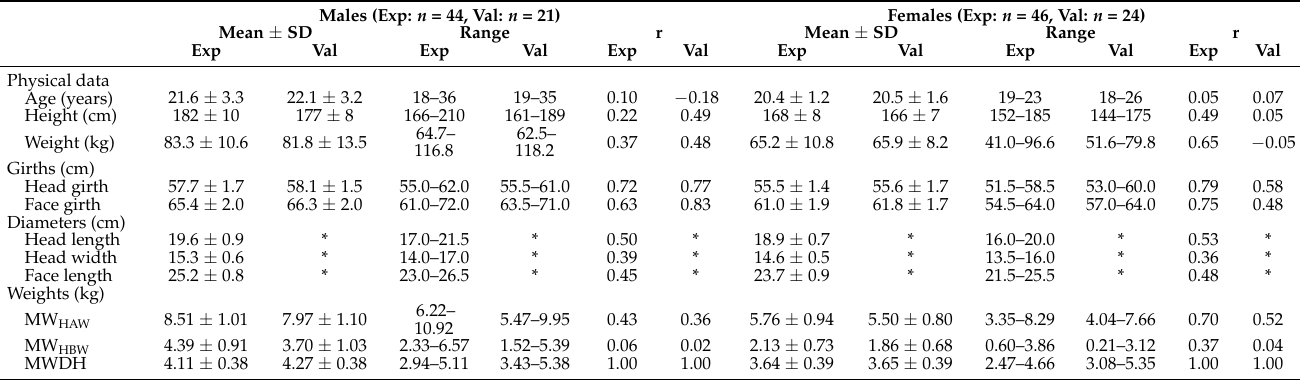
Table 1. Physical measurements and correlations with mass of water displaced by the head for experimental and validation